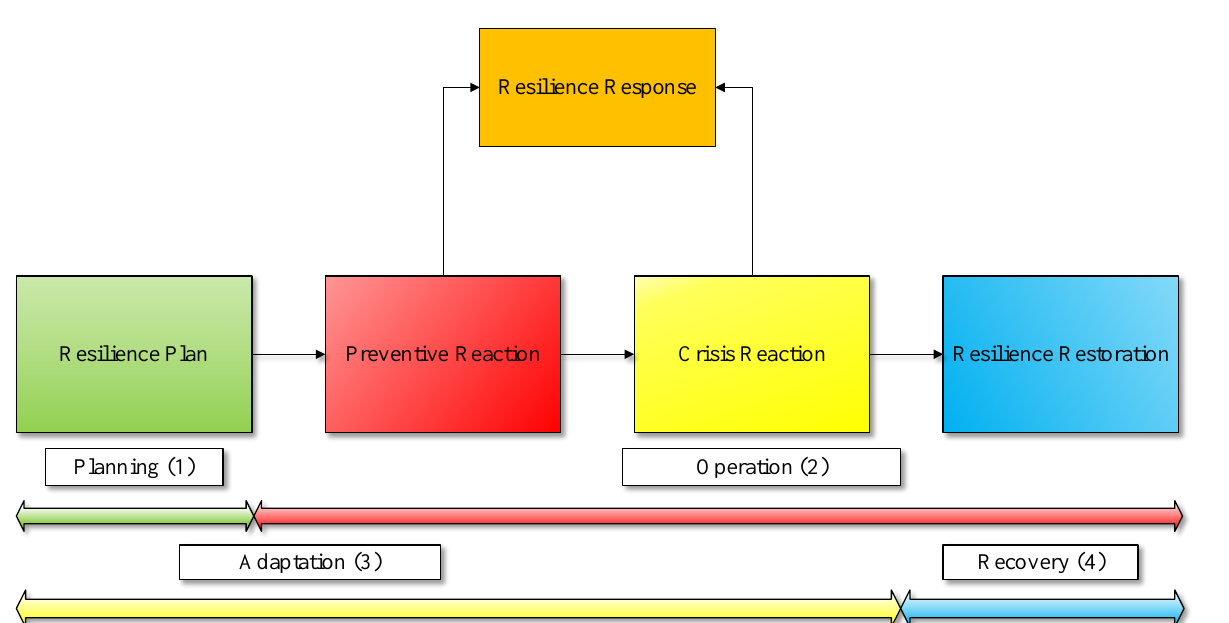
Figure 5. Resilience stages in campus microgrids.